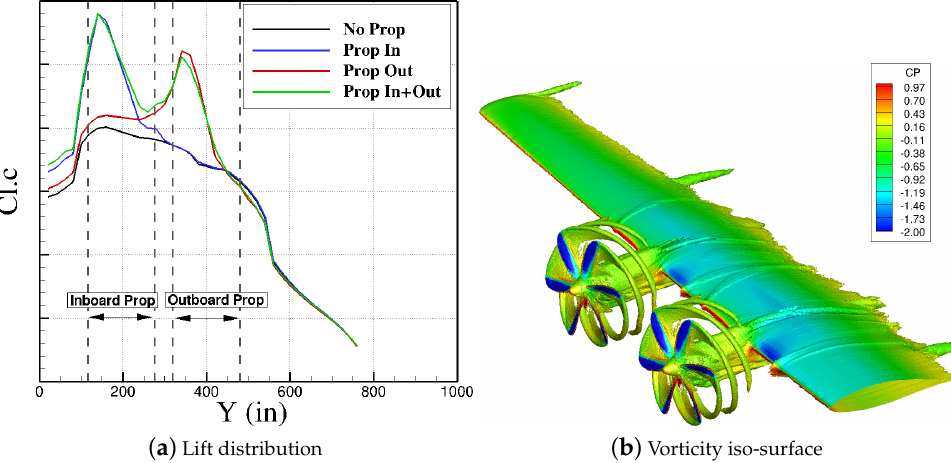
Figure 12. Propeller installed at both inboard and outboard wing; In ( a ), local lift distribution for wing and propellers installed inboard and outboard the wing are shown. In ( b ), vorticity isosurfaces are colored with pressure coefficient. Propellers have 20-deg blade angle and spin at 1024